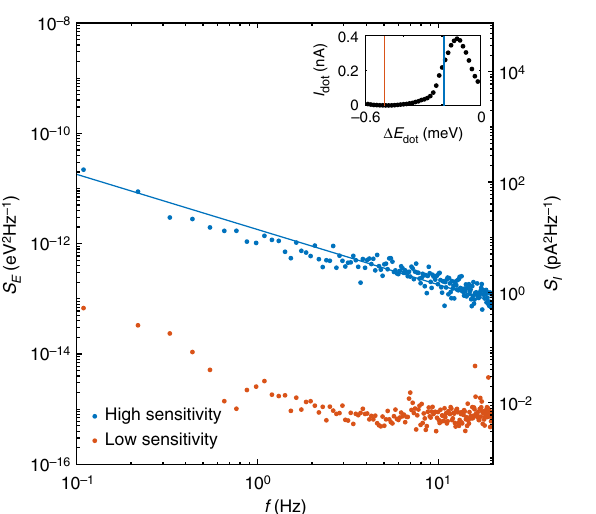
Fig. 4 Quantum dot charge noise spectrum. Current noise power spectrum for the quantum dot in transport (blue dots) and in Coulomb blockade (orange dots) as indicated in the inset. Solid line corresponds to an apparent linear fi t to the data, yielding a slope of − 1.00(4)